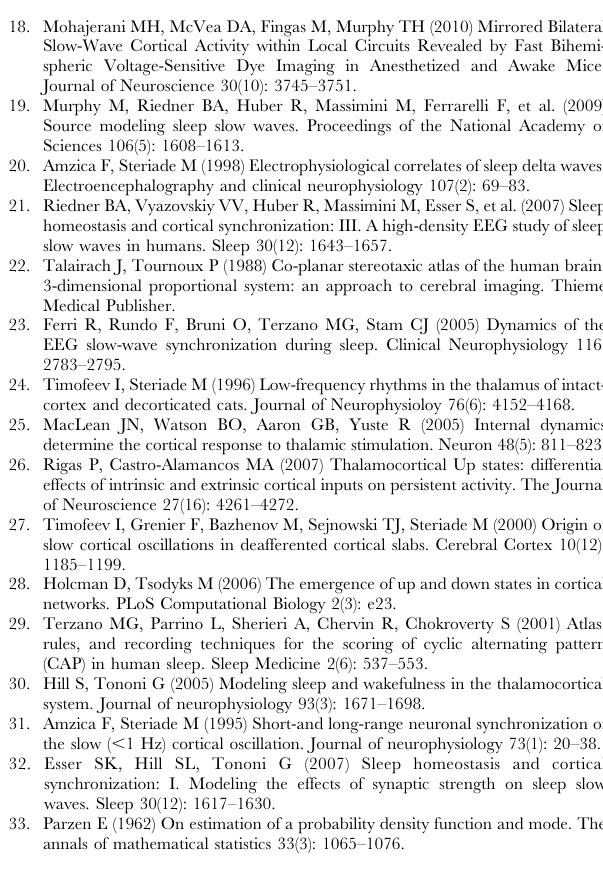
Figure S7 Example of the estimation of the speed of propagation. Histograms of the estimated speed (calculated as described in the text) for the H-wave and D-wave of subject S2. The mode peak is clearly visible. Figure S8 Illustration of the method for the study of the propagation. Top left : Percentage of the total number of events of a subject (S5) detected by each of its intracranial contacts. The dashed line corresponds to the threshold of one standard deviation. Top right : Detection probability vs. order of detection for each hub. This probability has been calculated over all the events of the subject. The black circles point the position of maximum detection probability of each hub. Bottom : Reconstruc- tion of the directed graph on the intracranial implantation (temporal implantation in this case) and a schematic representa- tion of the graph construction procedure. The blue spheres mark